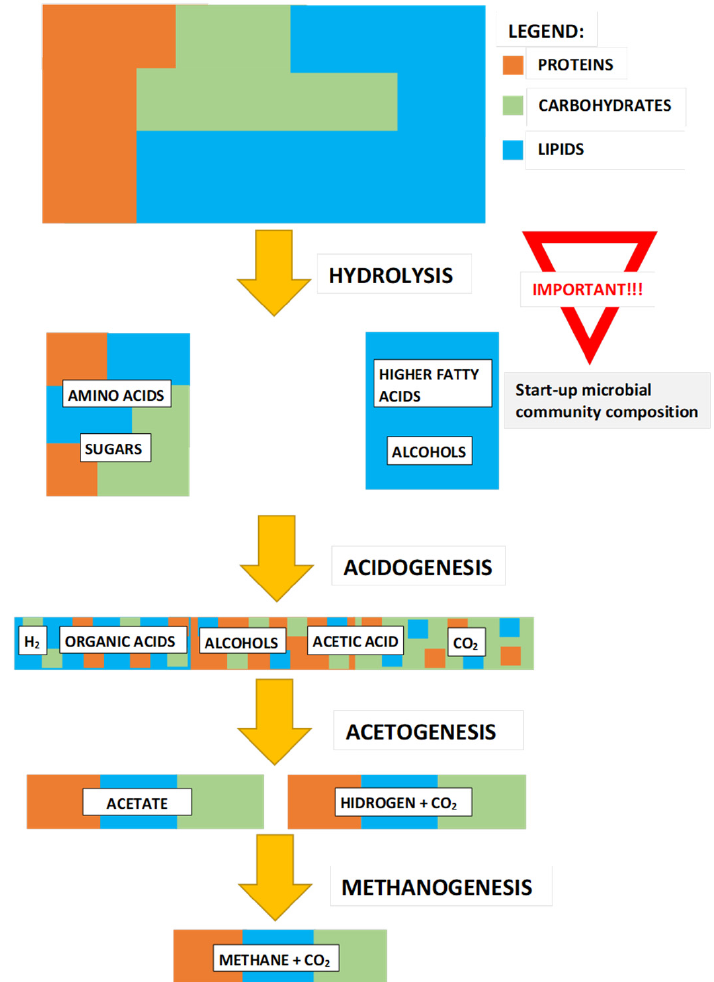
Figure 1. Phases of the anaerobic digestion process and their main products. Table 1. Breakdown of organic polymers and microorganisms involved (adapted from